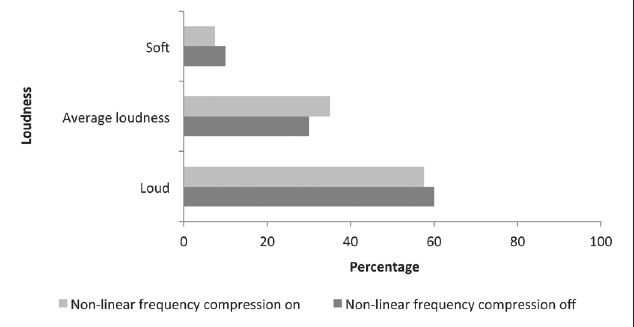
Fig. 2. Participants’ perception of musical loudness with NFC off versus NFC on.